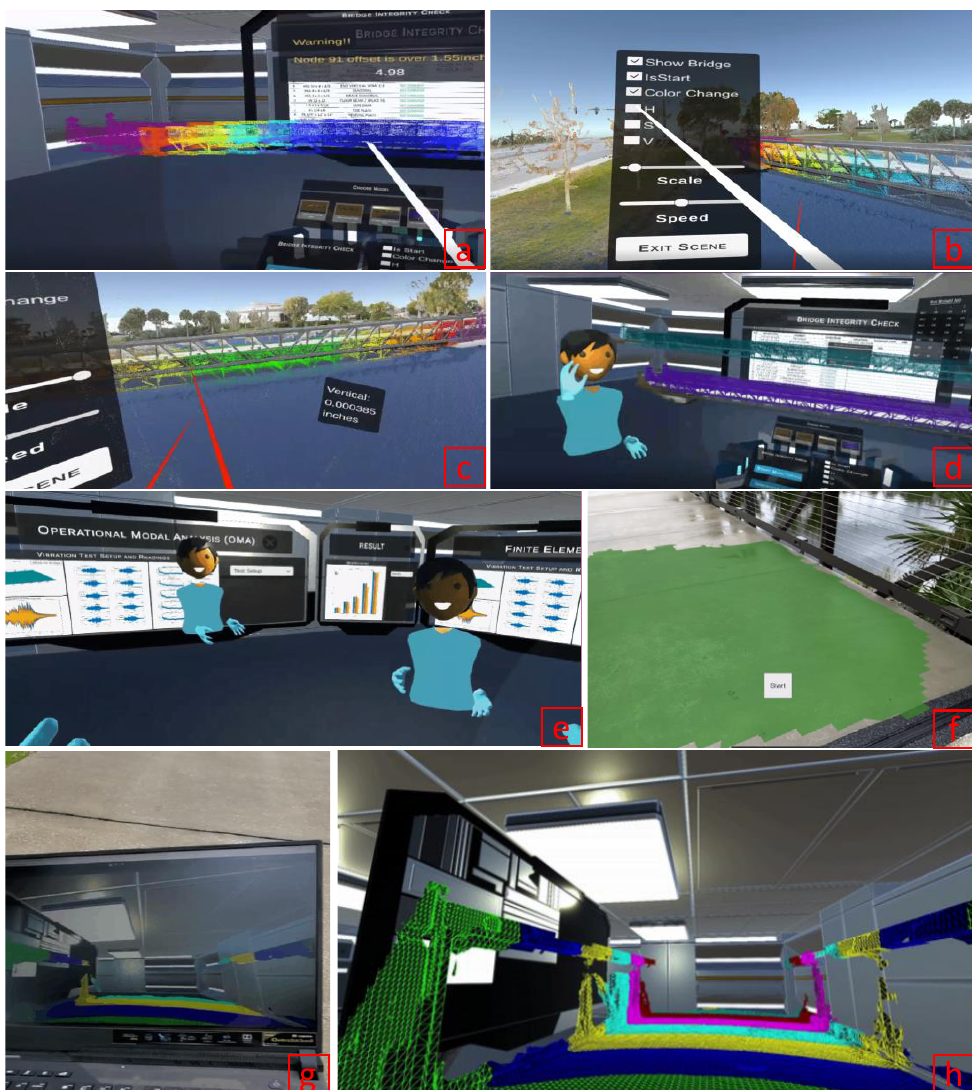
Figure 13. ( a ) FEA reflected TLS point cloud with serviceability limit state check warning and dynamic monitoring of the midspan; ( b ) configuration panel of the FEA reflected TLS point cloud in immersive view; ( c ) dynamic monitoring of the all nodes with VR controller in immersive view; ( d , e ) multi-user feature; ( f ) iPad screen—iPad LiDAR footbridge scanning; ( g , h ) iPad LiDAR real-time footbridge reconstructing in the VR environment